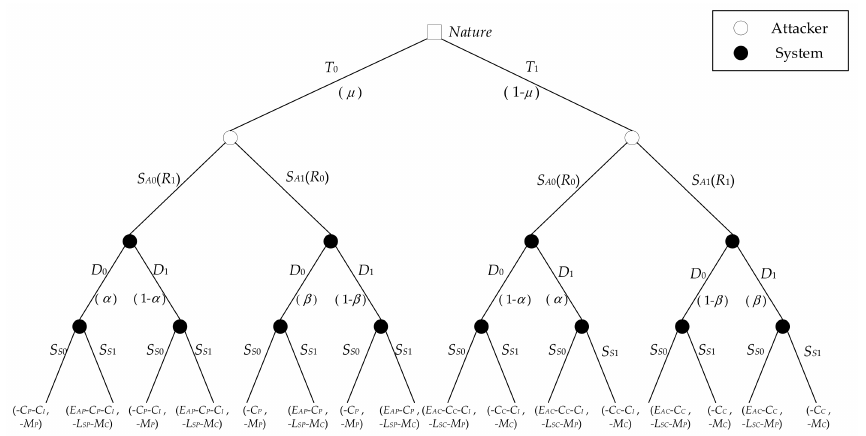
Figure 4. The Process of Offensive and Defensive